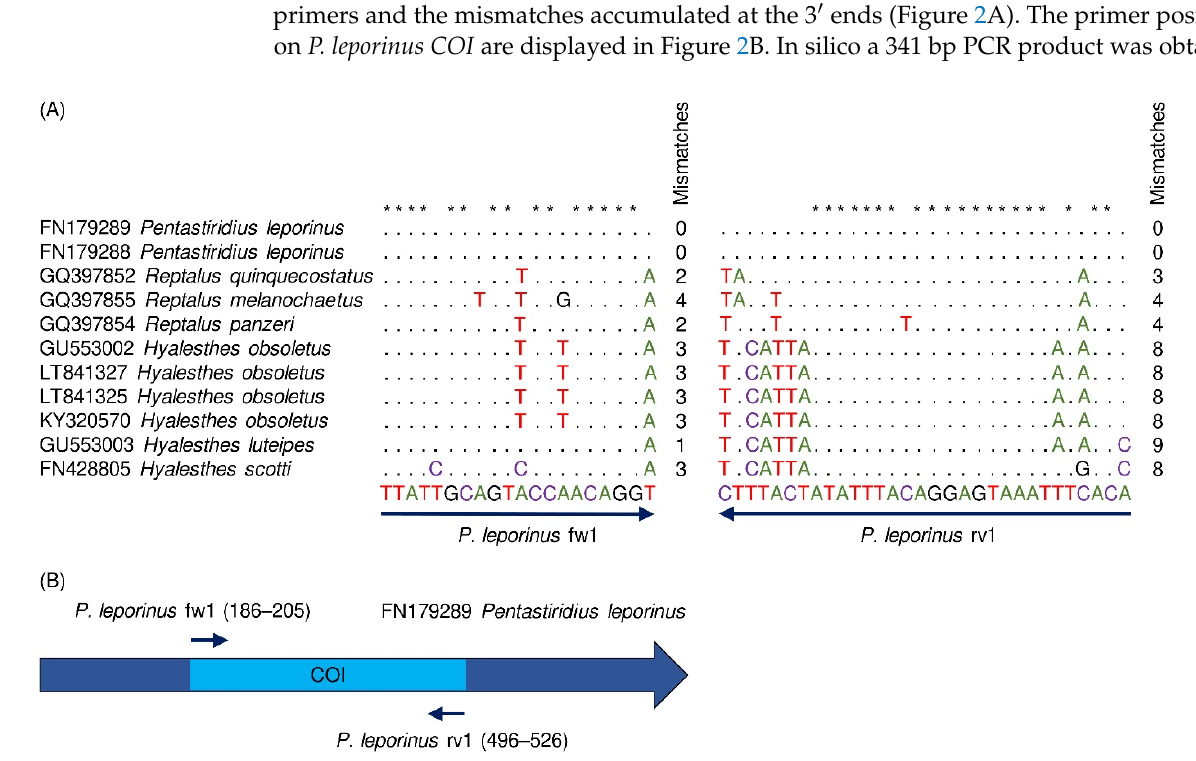
Figure 2. Alignment of the specific primers ( P. leporinus fw1 and rv1) to the COI gene of Pentastiridius leporinus and different members of Reptalus spp. and Hyalesthes spp. ( A ) Dots mark identical nucleotides in the specific primers and the analyzed sequences. Asterisks mark the positions of conserved nucleotides within primer sequences. Nucleotide mismatches between primers and analyzed sequences are highlighted with letters and numbers indicated for each sequence. ( B ) The schematic map represents the location of specific primers on the partial COI gene. Arrows represent the locations of the primers which amplify a 341 bp fragment (light blue) on P. leporinus COI sequence available from the NCBI database (dark blue).